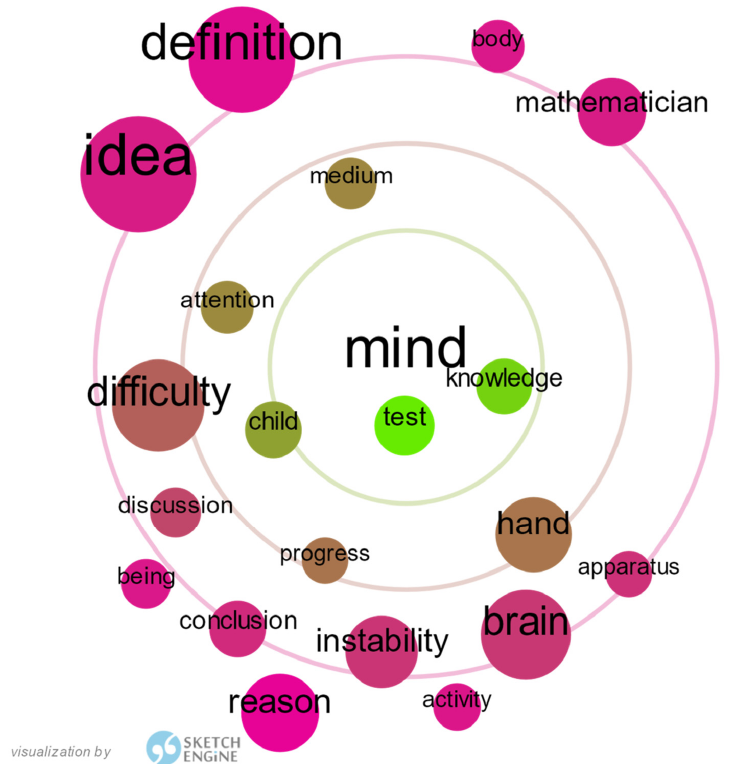
Figure 3. This diagram depicts terms semantically close to the term “mind” in Turing’s corpus.